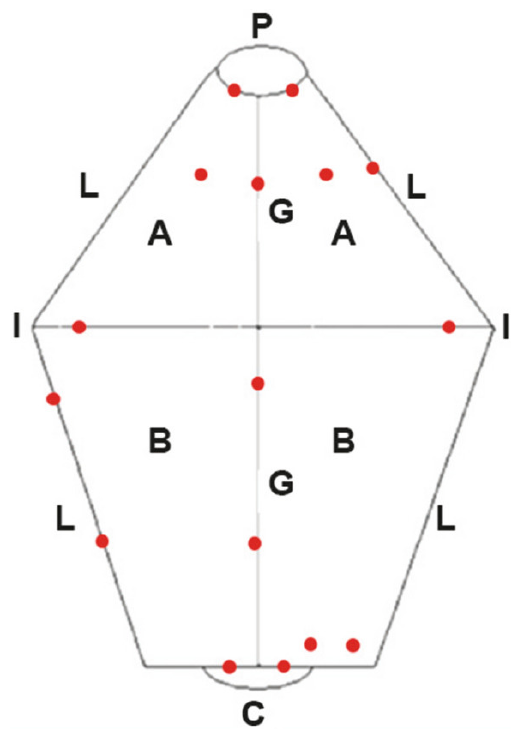
Figure 1. Schematic map of the stomach showing standard biopsy sites (red dots) used for non- targeted gastric mucosal sampling (modified from Simone et al. [17]). A: antrum; B: gastric body; G: greater curvature; L: lesser curvature; P: pylorus; I: incisura angularis (angular fold); C: cardia.